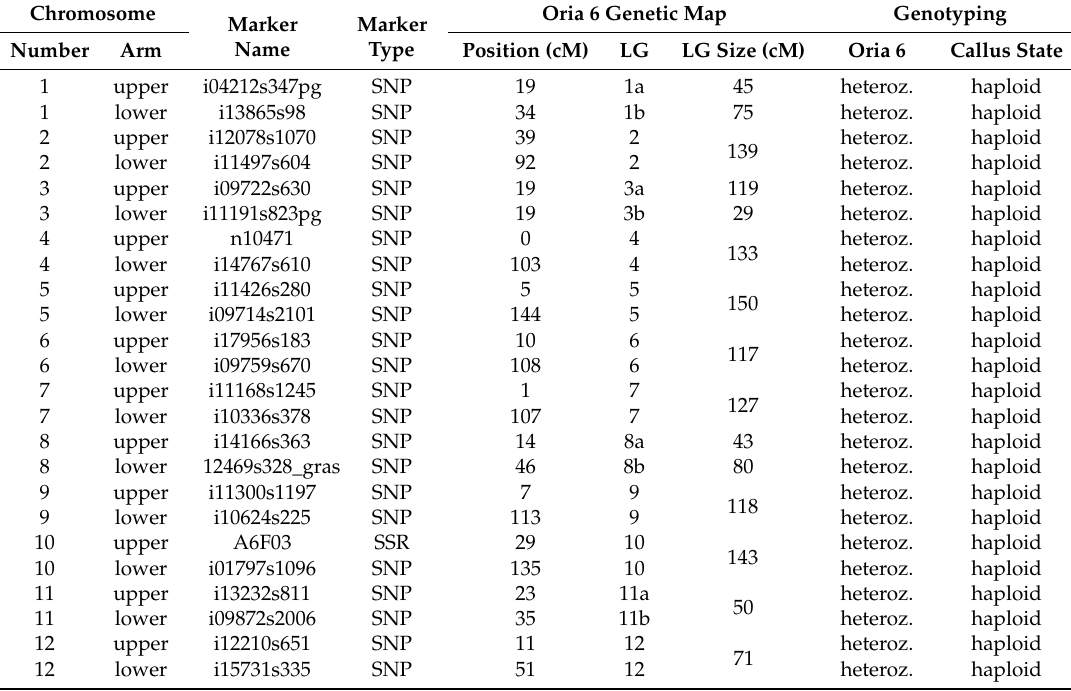
Table 2. Molecular markers used to validate the presence of all chromosome arms. The position of each marker on the Oria 6 genetic map [29] as well as the allelic state of the mother tree (Oria 6) and L5 line (callus) are